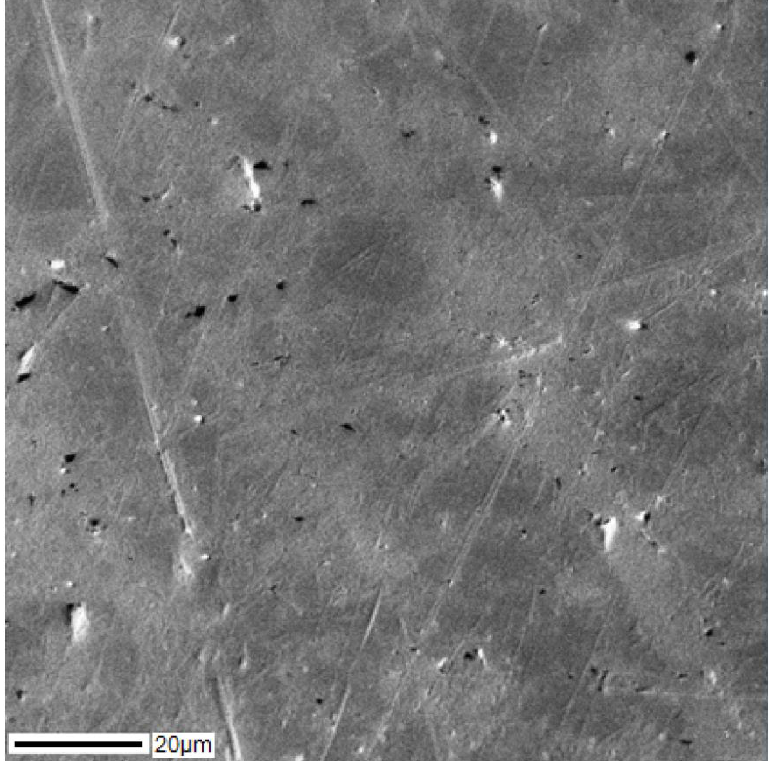
Figure 1. The dendritic structure of the Ti–28Nb–5Zr alloy after seven-fold remelting obtained using scanning electron microscopy (SEM).